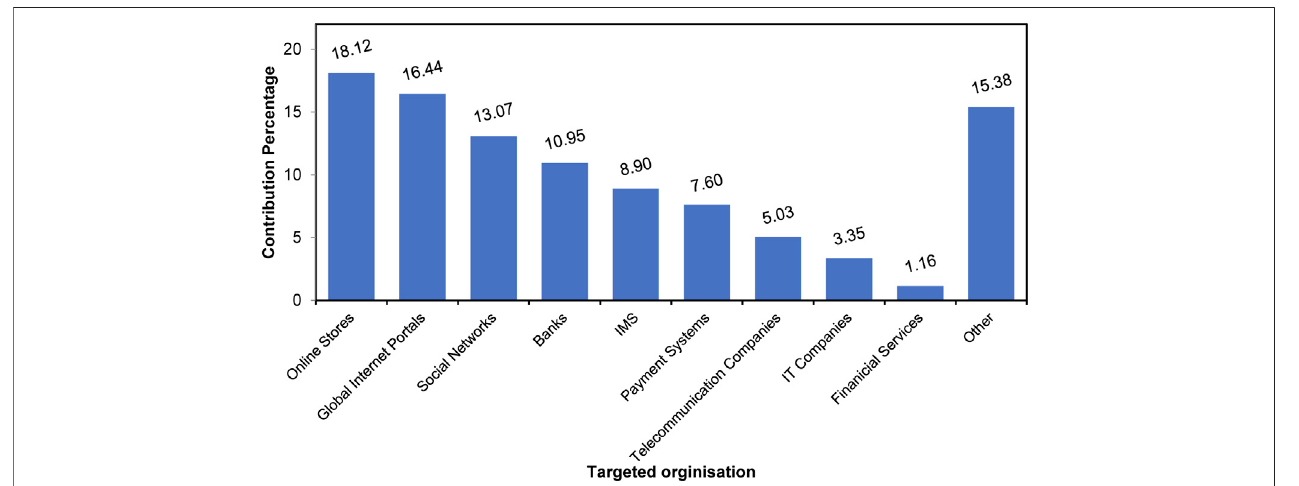
FIGURE 6 | Distribution of organizations affected by phishing attacks detected by Kaspersky in quarter one of 2020.